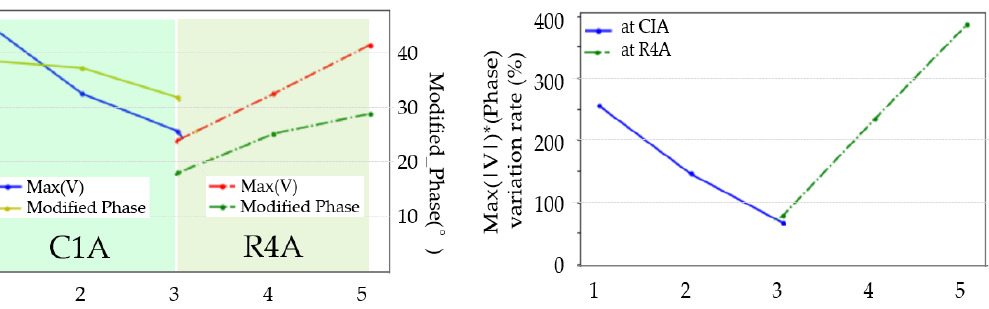
Figure 10. Voltage and phase variation according to MO’s position .